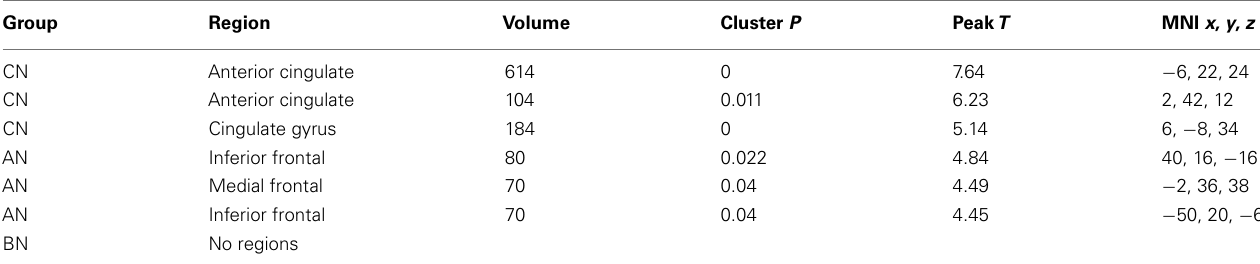
Table 5 | Clusters in the CN,AN, and BN group maps during the Self–Friend contrast of the physical identity task.